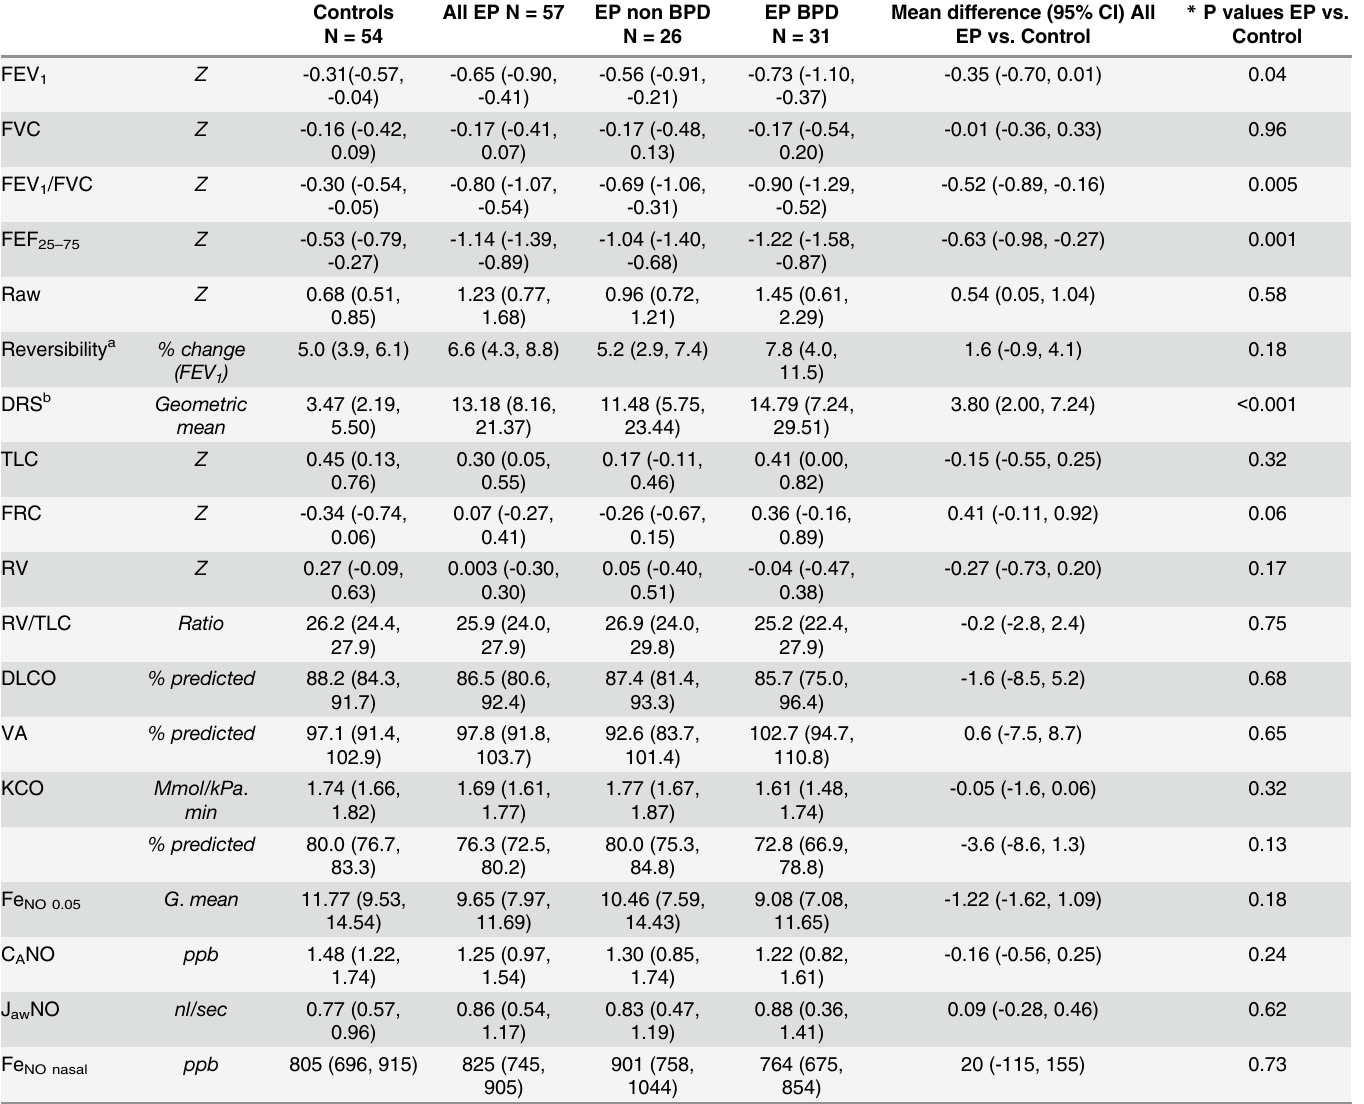
Table 3. Lung function variables in 11 year old children born preterm (EP) in 1999 – 2000 and matched term-born controls, split by neonatal bronch- opulmonary dysplasia